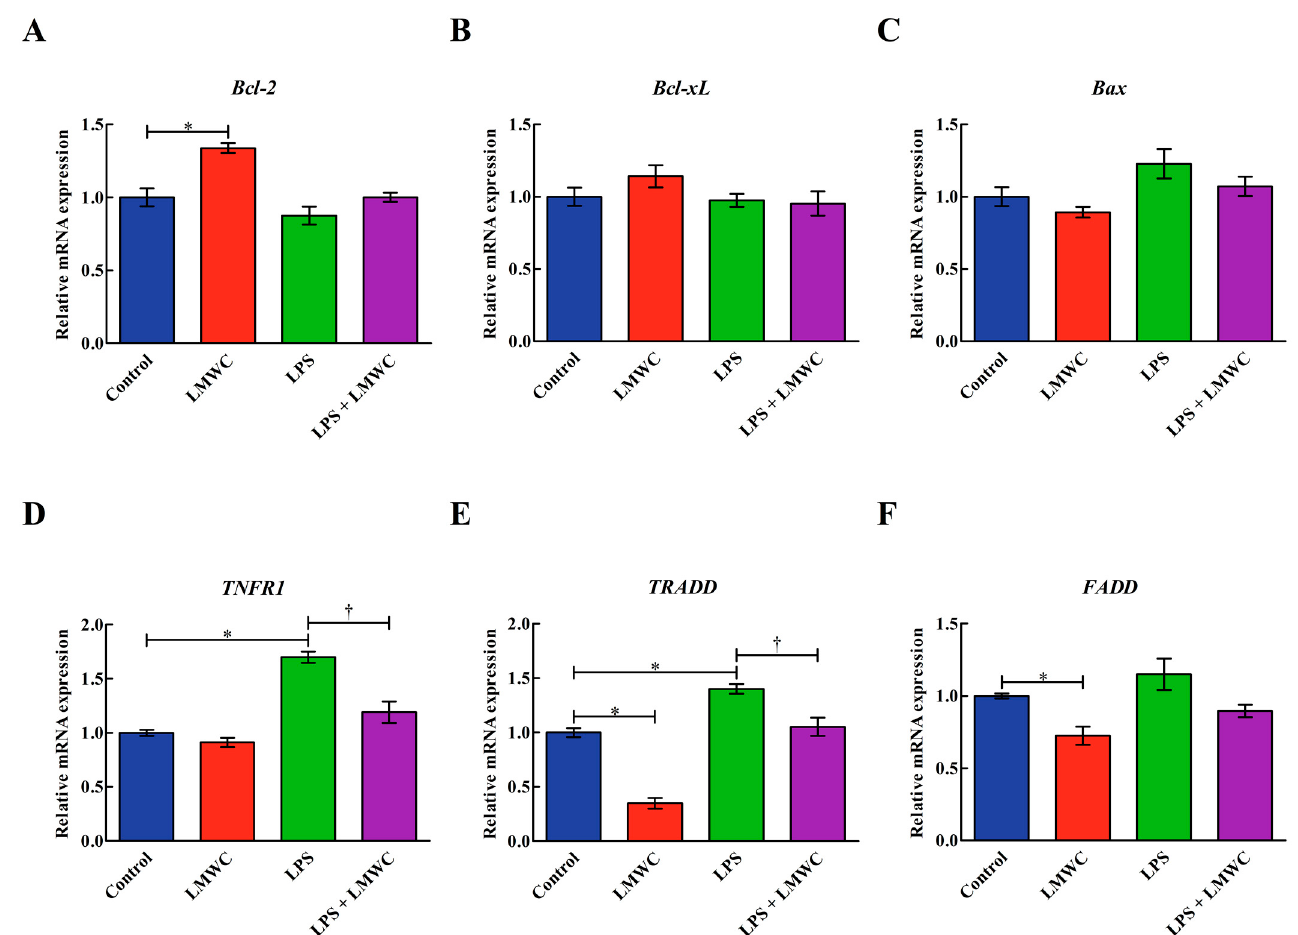
Figure 7. Effects of LMWC on the mRNA levels of apoptosis-related genes in LPS-treated IPEC-J2 cells. ( A ) Bcl-2 : B-cell lymphoma-2. ( B ) Bcl-xL : Bcl-2-like-1. ( C ) Bax : B-cell lymphoma-2-associated X protein. ( D ) TNFR1 : tumour necrosis factor receptor 1. ( E ) TRADD : tumour necrosis factor receptor-associated death domain. ( F ) FADD : Fas-associated death domain. Cells were pretreated with LMWC (400 µ g/mL) for 2 h, followed by cotreatment with LPS (5 µ g/mL) for another 6 h. Data are presented as the mean ± standard error ( n = 4). * Means significant difference compared with the control group ( p < 0.05). † Means significant difference compared with the LPS group ( p < 0.05).